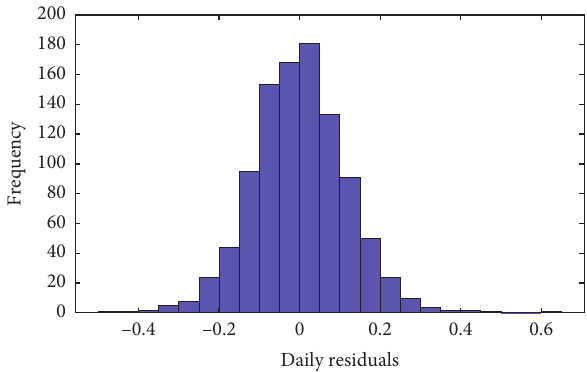
Figure 13: The simulated return series.